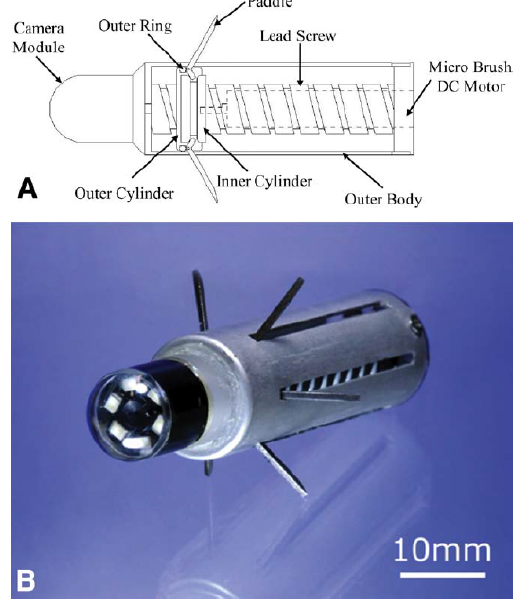
Figure 4. Paddling-based locomotive capsule endoscope. ( A ) Illustration of the paddling-based locomotive capsule endoscope; ( B ) the complete paddling-based locomotive capsule endoscope with fully stretched legs. Adapted from Kim et al. [22] with permission from Elsevier.